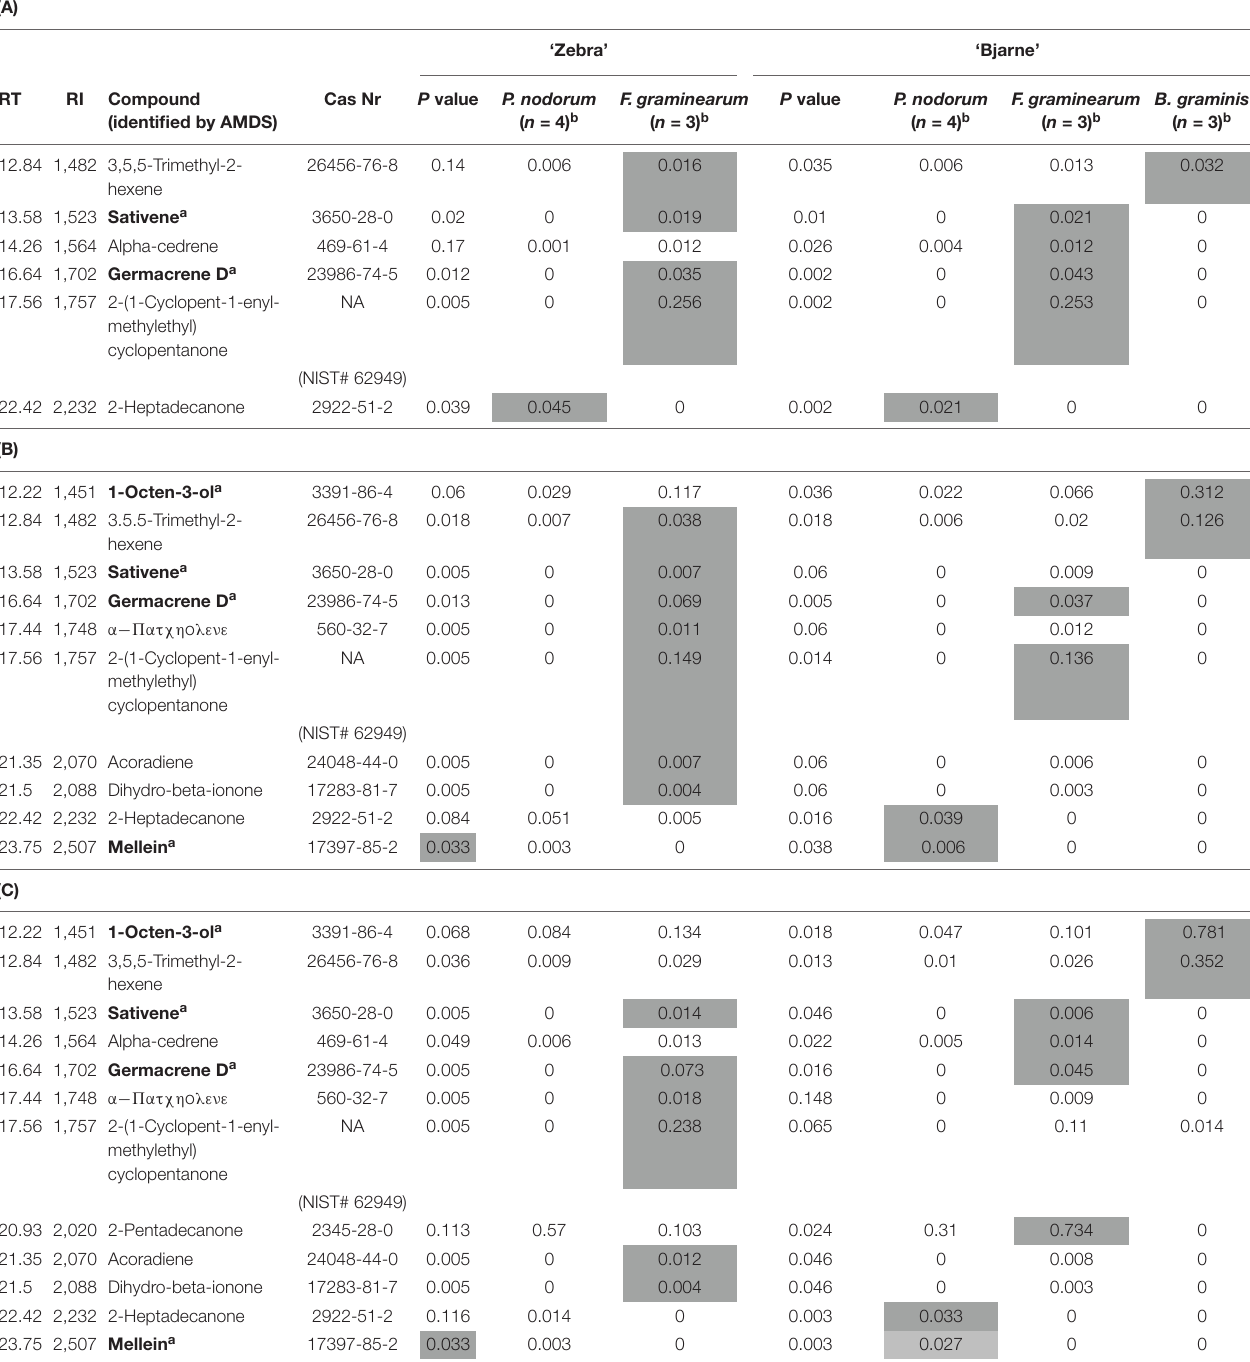
TABLE 3 | Volatile organic compounds in headspace collections from potted wheat plants (‘Zebra’ and ‘Bjarne’) 7 (A), 14 (B), and 21 (C) days after inoculation with Fusarium graminearum or Parastagonospora nodorum . Mean release rates of compounds trapped over 24 h are presented as heptyl equivalents per pot. The amounts of the different compounds are given in medians. If the P value was less than 0.05, one treatment median per variety was significantly different from the rest (Kruskal–Wallis test, gray cells). P values were adjusted for ties. Only compounds that were produced in significantly higher amounts than from the control are listed in the